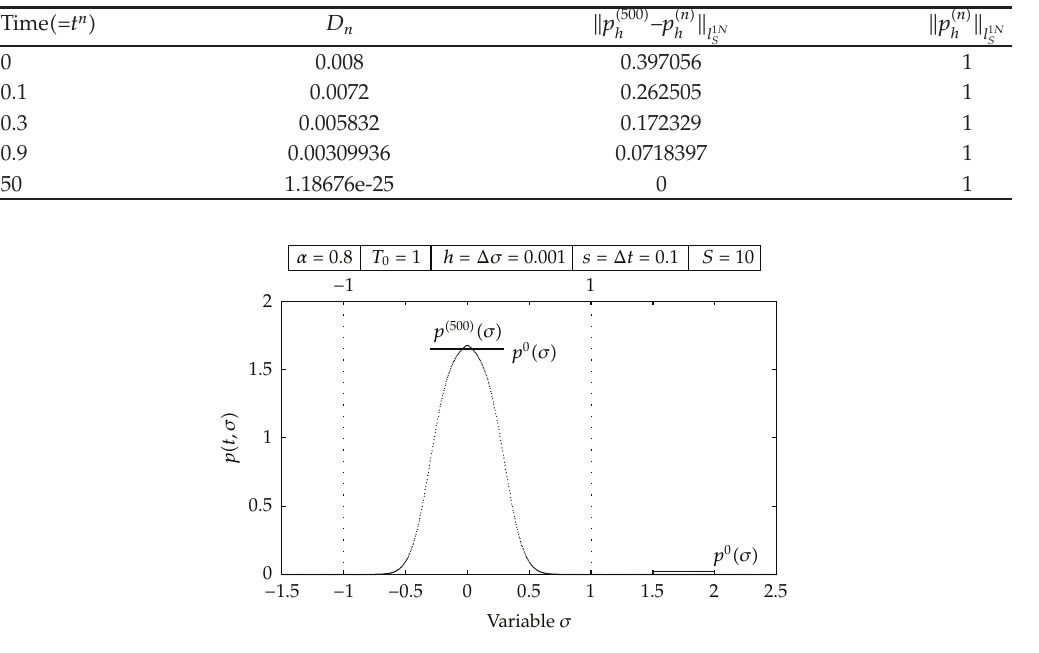
Figure 6: Graphics sequence: Subcase 4.